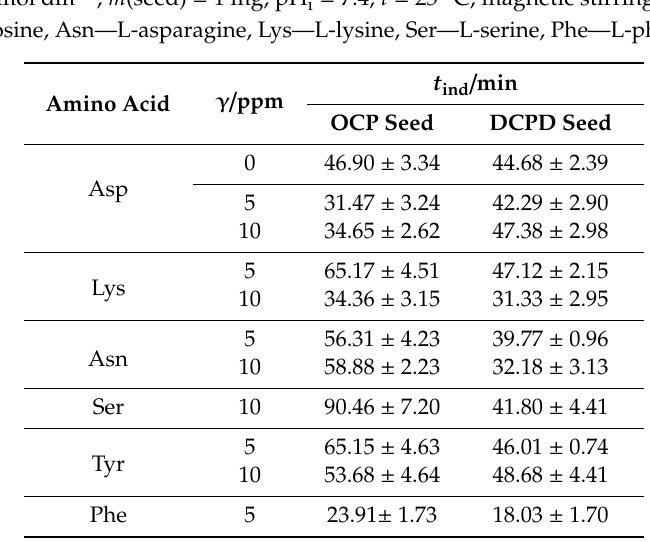
Table 1. Average induction times ( t ind ) obtained from pH vs. t curves (Figure S1) from five measurements expressed with standard deviation. c (CaCl 2 ) = c (Na 2 HPO 4 ) = 4.198 mmol dm − 3